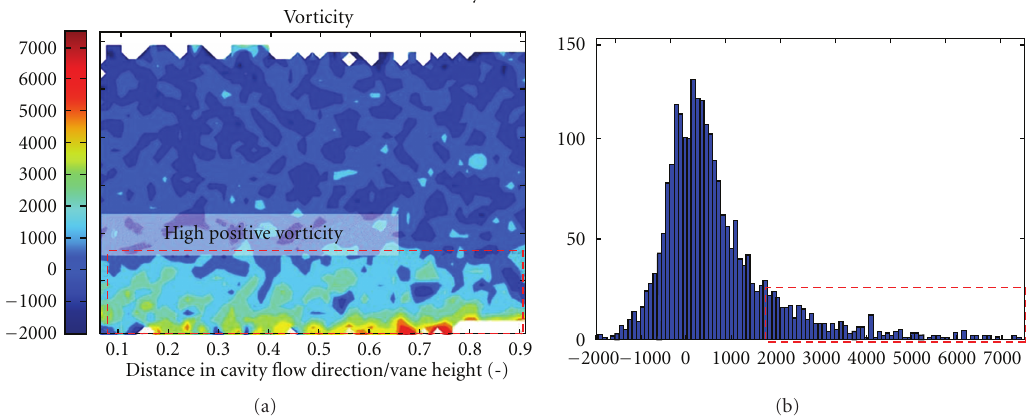
Figure 19: Vorticity plot showing counterclockwise flow rotation over the RVC (a); vorticity histograms (b), Position 4, 12 mm from combustion